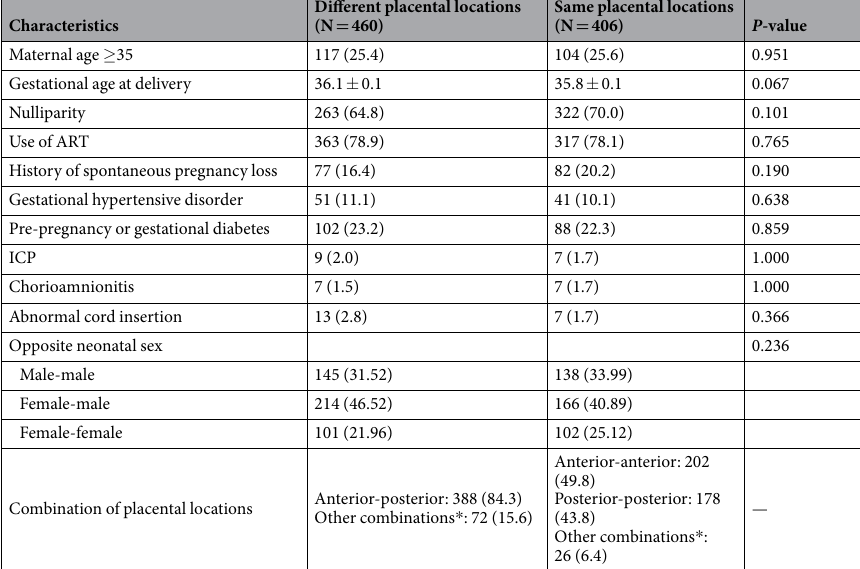
Table 1. Maternal and fetal characteristics by placental locations. ART, assisted reproductive technology; ICP, intrahepatic cholestasis of pregnancy. * Placental location combination involved fundal or lateral